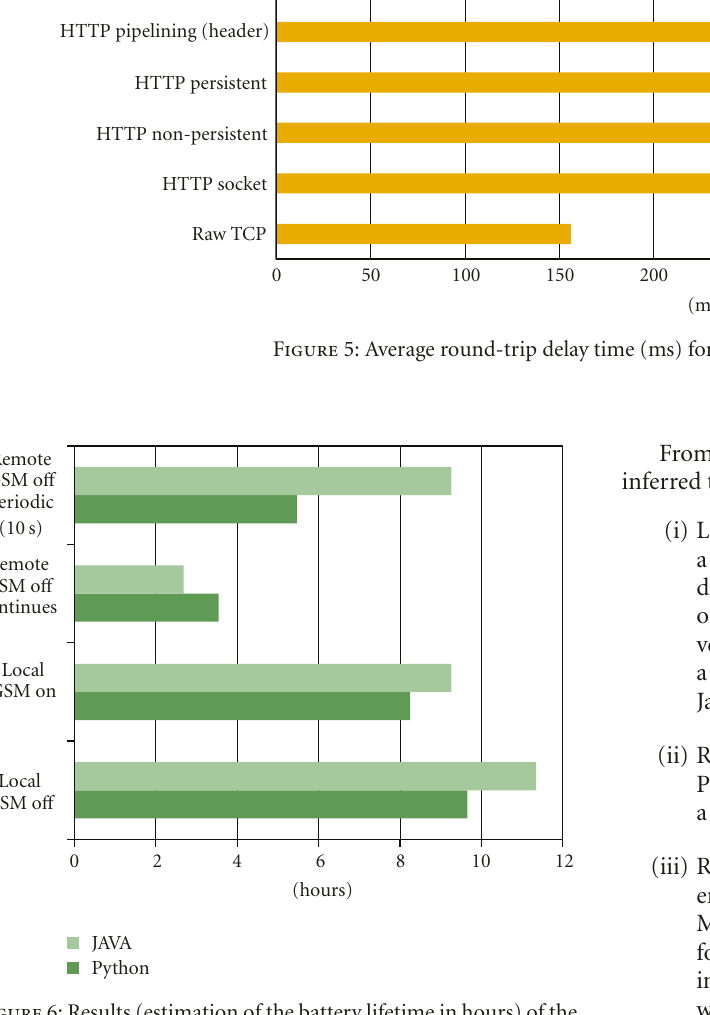
Figure 6: Results (estimation of the battery lifetime in hours) of the autonomy tests for the NC